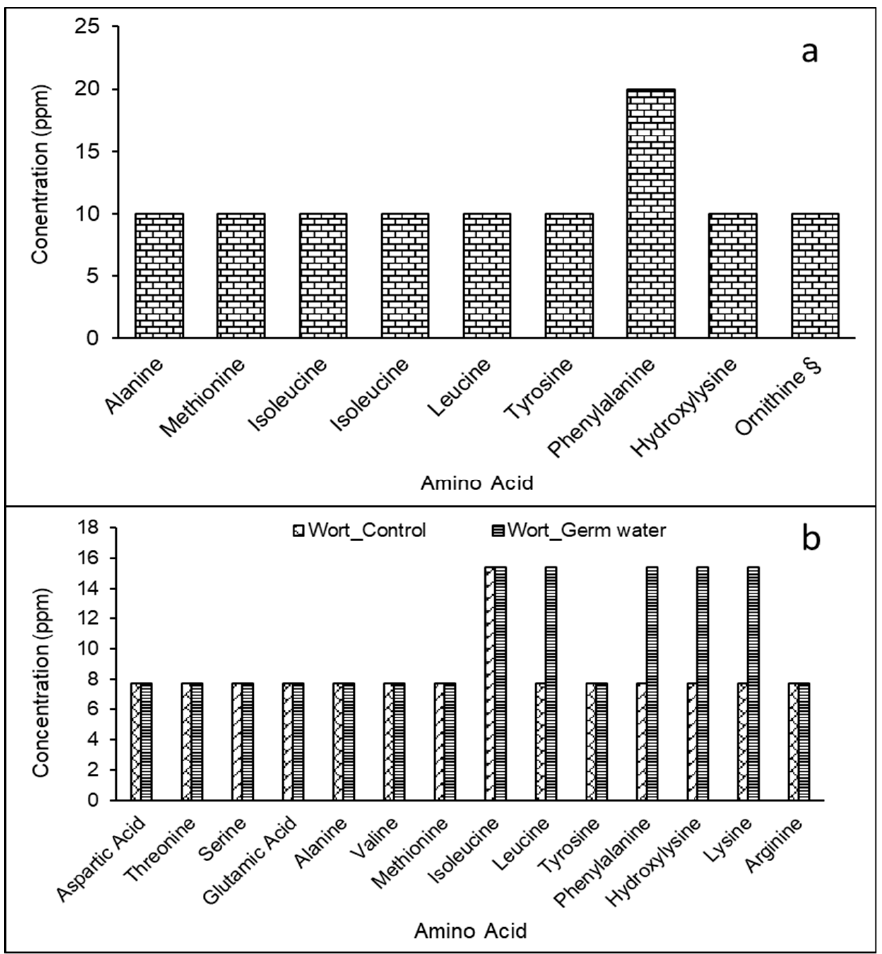
Figure 4. Amino acid concentrations in ( a ) liquid obtained after germ soaking and ( b ) wort from wort obtained from control samples and from germ water supplemented samples. Data in Figure 4a is average of two replications.